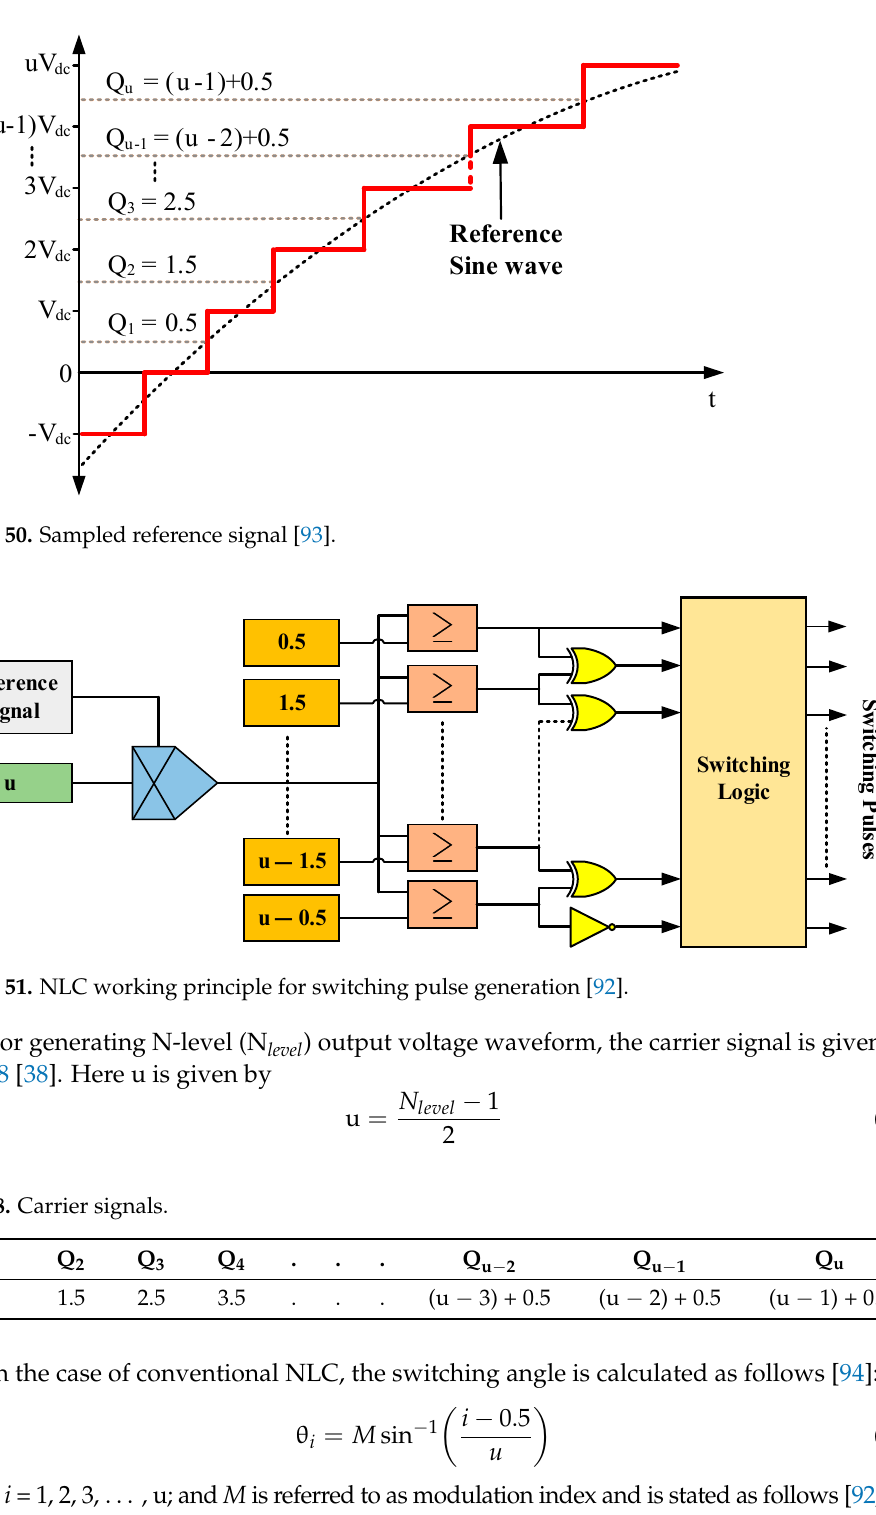
Table 8. Carrier signals.